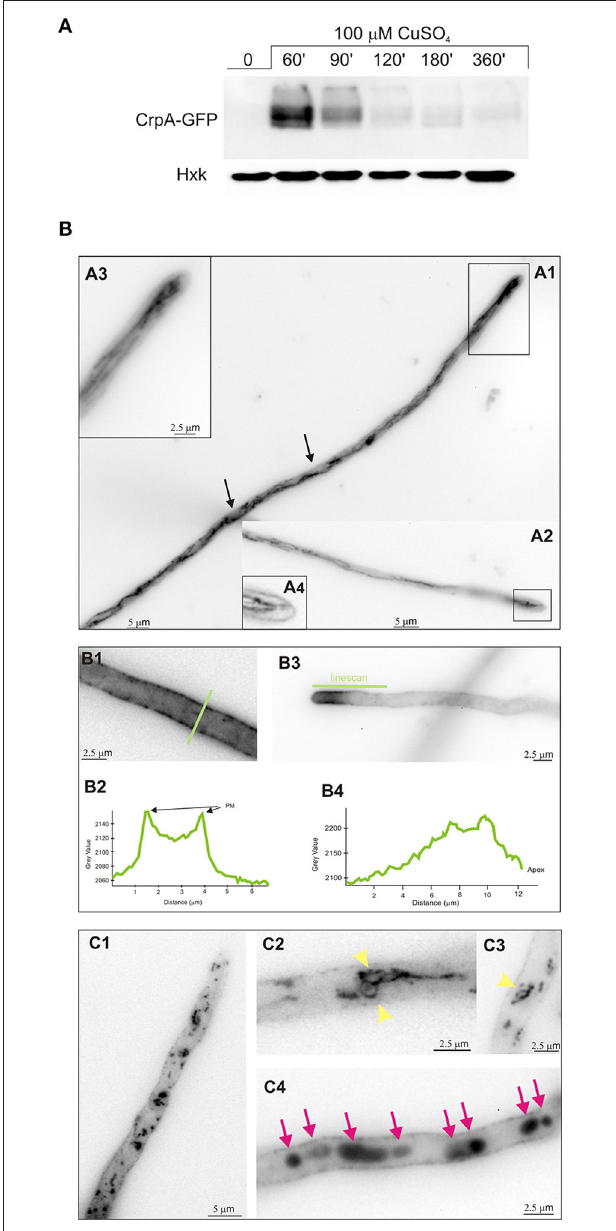
FIGURE 4 | Effect of copper in intracellular localization of CrpA-GFP. (A) Western blot confirming CrpA-GFP normal expression kinetics after addition of 100 µ M of CuSO 4 (B) Cells of a strain expressing a CrpA–GFP fusion were grown in selective medium for microscopy for 16 h at 25 ◦ C and shifted to medium containing 100 µ M CuSO 4 for the indicated times. Images taken 30 min after the shift. (A1,A2) CrpA localized in a network of strands and tubules. (A3,A4) Images corresponds to the rectangular region indicated in (A1,A3) showing a magnification of the tip region. (B1–B4) Images corresponding to 1 h after the shift. GFP fluorescence was accumulated predominately in the PM (B1) and polarized in the tip region (B3) . Panels (B2,B4) corresponds to the line scans of CrpA-GFP signal across the indicated lines. (C1–C4) Images taken 2–3 h after shifting. Panels (C1,C2,C3) are examples of ring-shaped structures (yellow arrowheads) and (C4) of abnormal aggregates (magenta arrows). Images were treated with sharp filter, shown in inverted gray contrast and represent average intensity projections of